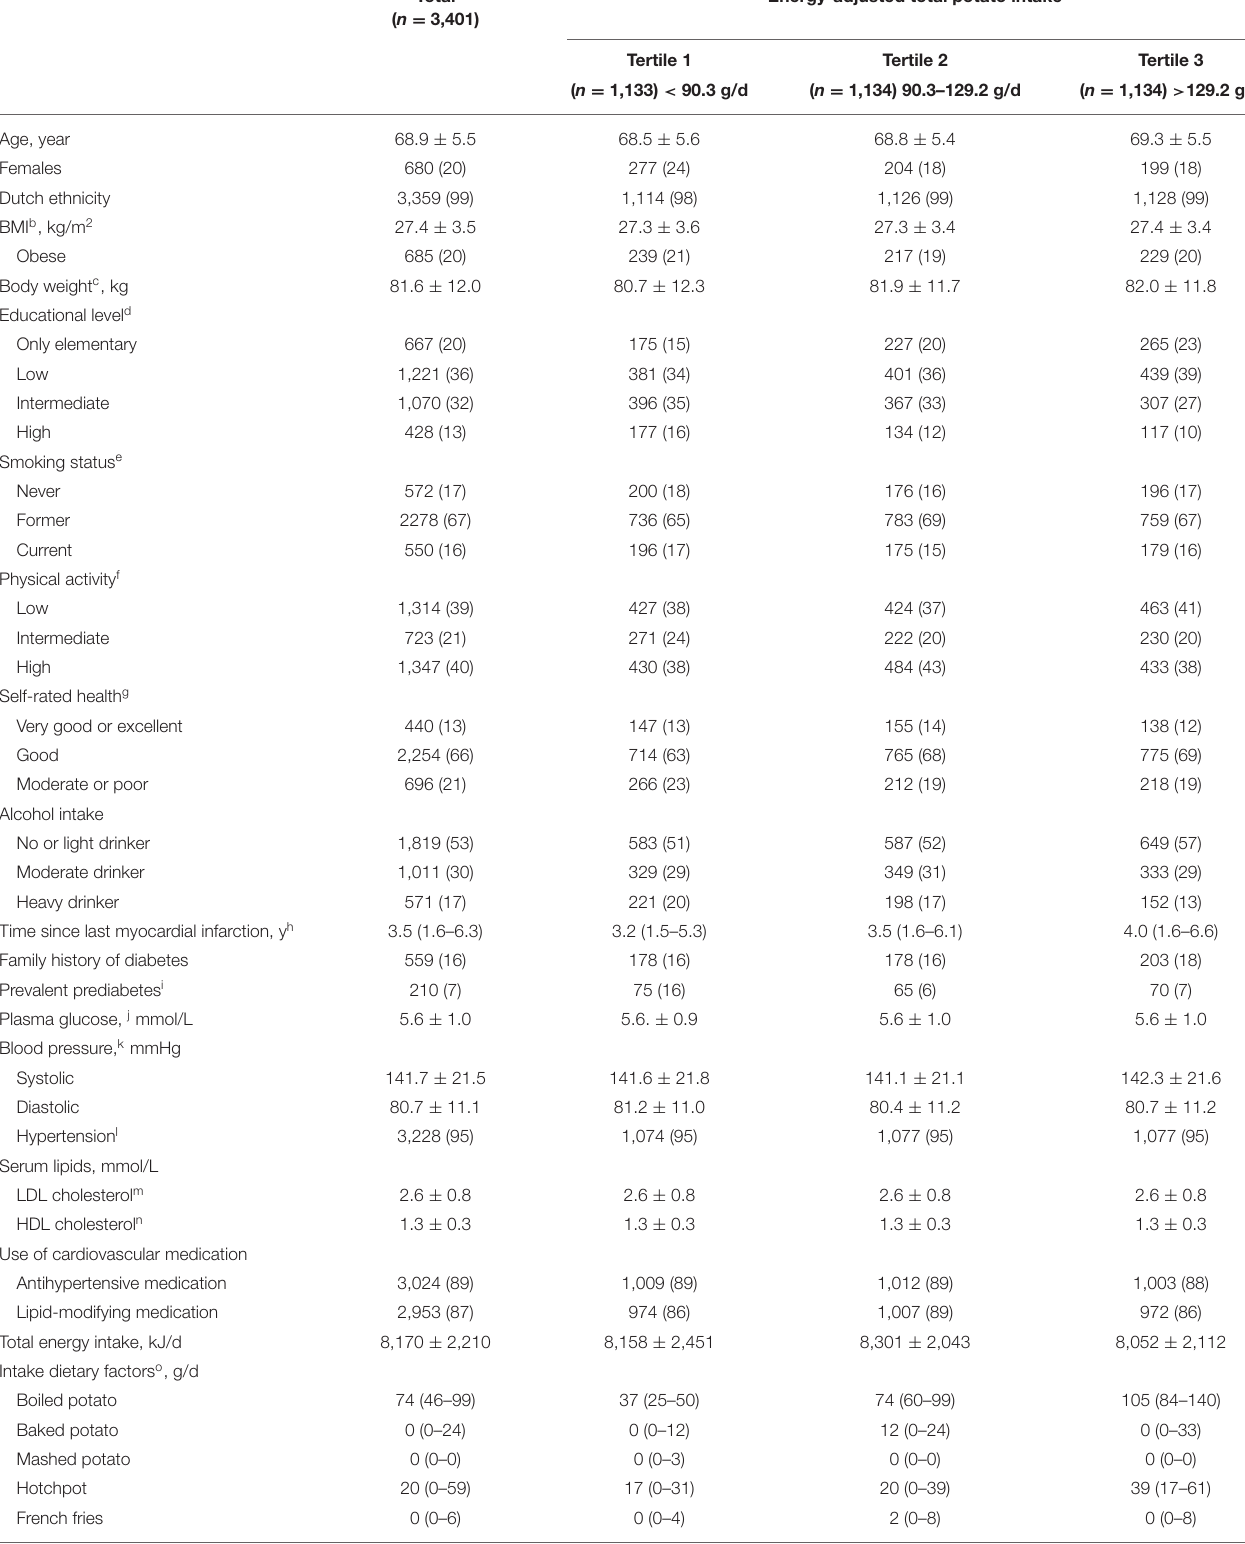
TABLE 1 | Baseline characteristics of 3,401 patients of the Alpha Omega Cohort, overall, and in tertiles of total potato intake a